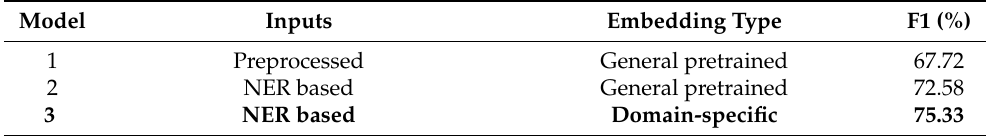
Table 2. Summary of results for RNN